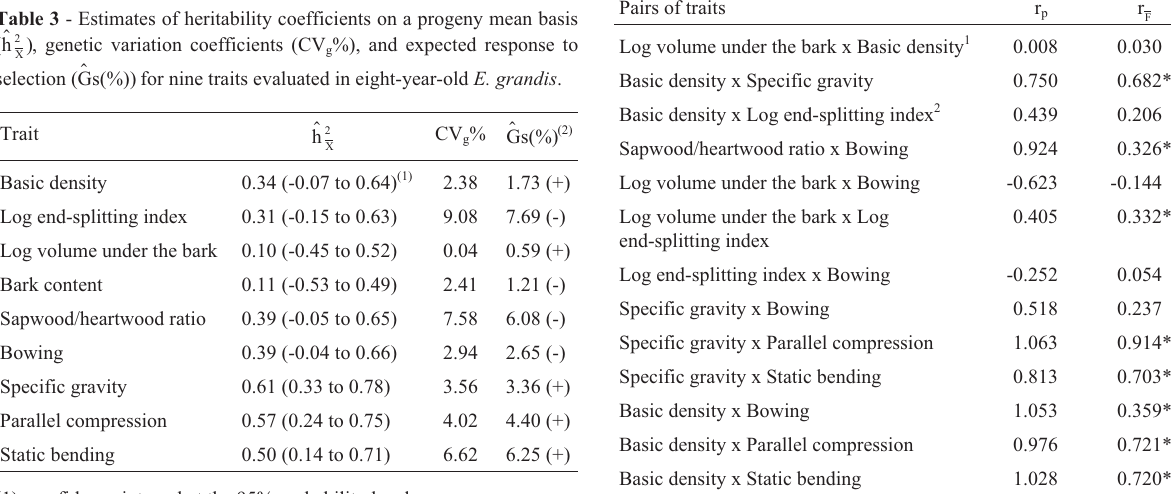
Eccentricity Bark content Sapwood/ Bowing Crooking under the heartwood bark ratio